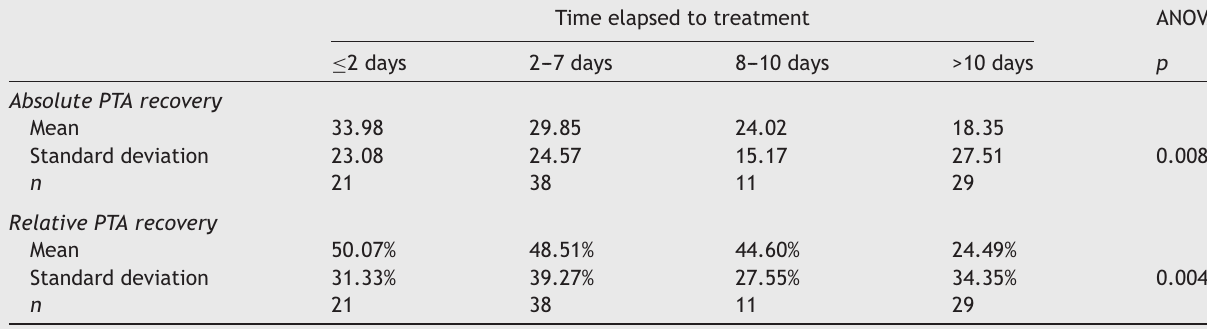
ANOVA tests among groups for time elapsed to treatment and recovery